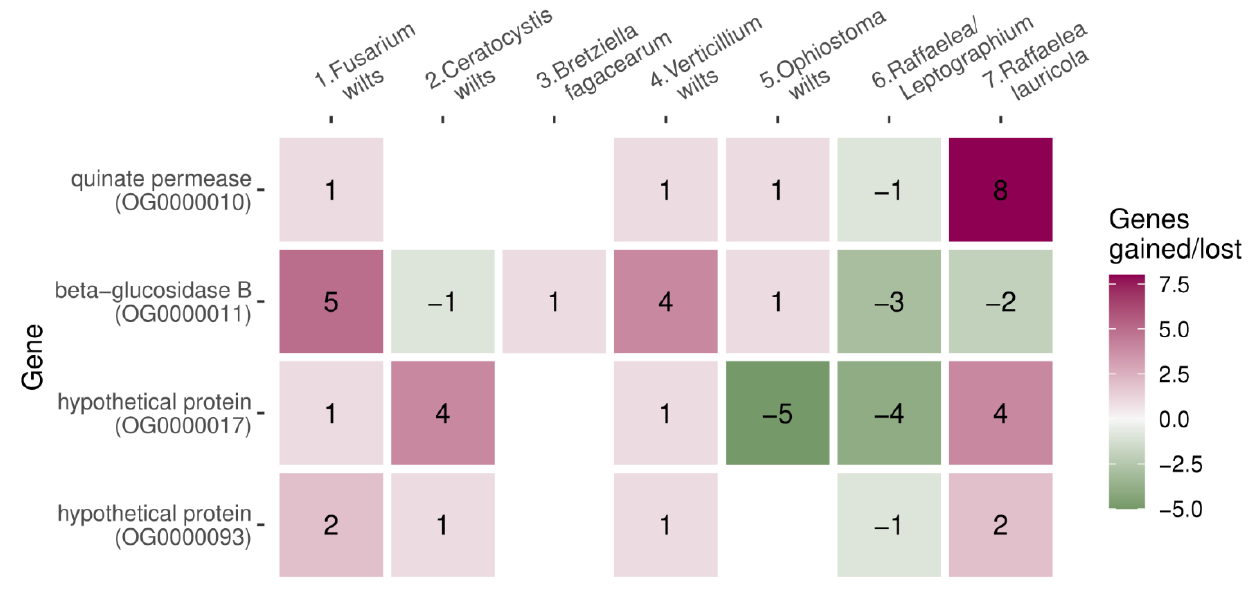
Figure 5. Gene families that diversified simultaneously in ancestral nodes of four wilt groups. Numbers indicate the number of gained or lost genes in the ancestor.